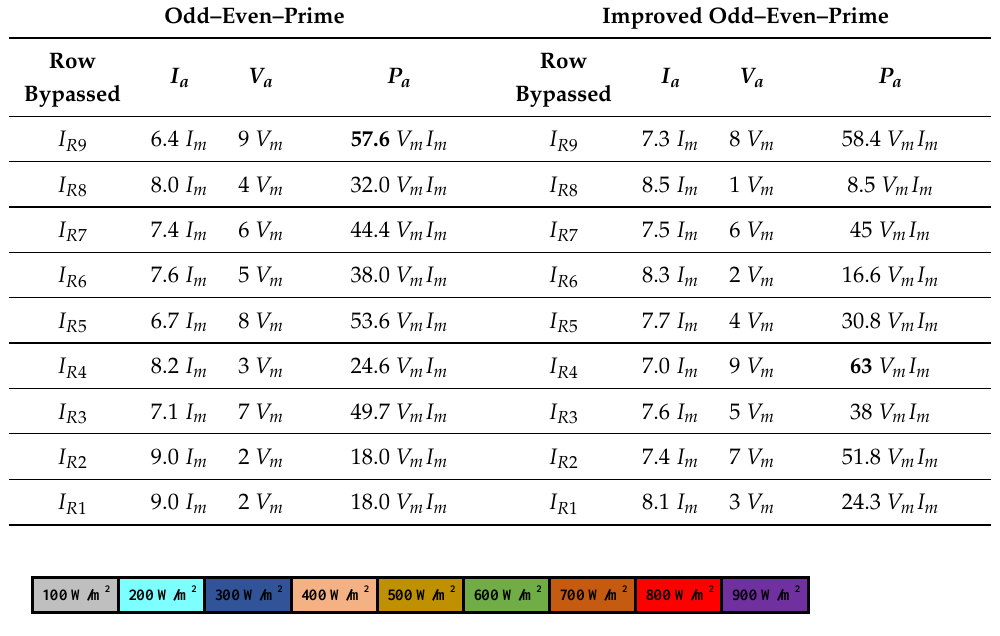
Table 4. GMPP for 9 × 9 PV array for Case-III (Bottom-Left) PSC.